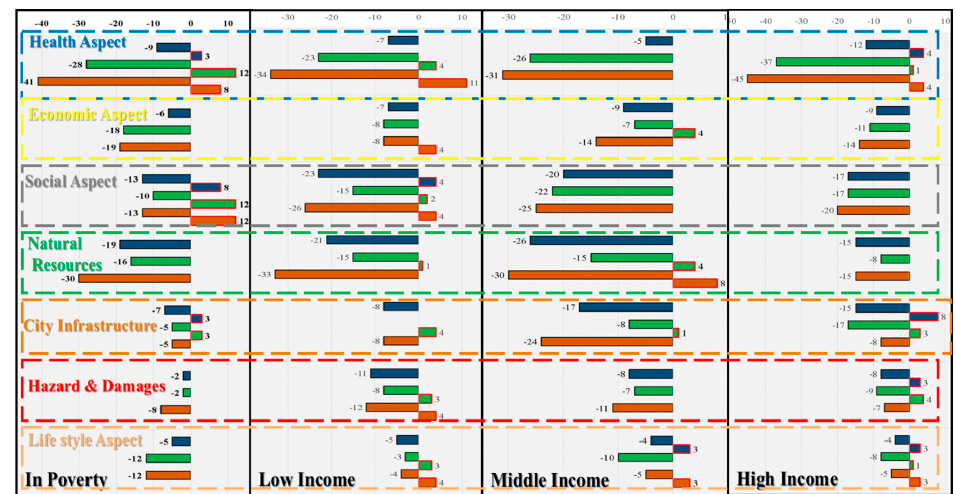
Figure 10. Comparing the effect of different scenarios on concepts per sector and income group. It should be highlighted that the negative numbers show the decrease in negative impacts (concepts) and positive numbers shows the increase in negative impacts. Legend: Blue bar represents the scenario: public health; green bar represents the scenario: water and electricity system; orange bar represents the scenario: transit system.